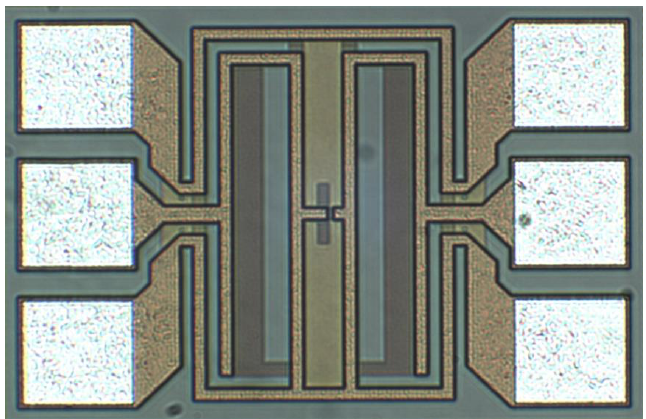
Electronics 2020 , 9 , x FOR PEER REVIEW Figure 9. Die microphotograph of the proposed bandpass filters (BPF) . Figure 9. Die microphotograph of the proposed bandpass filters (BPF).